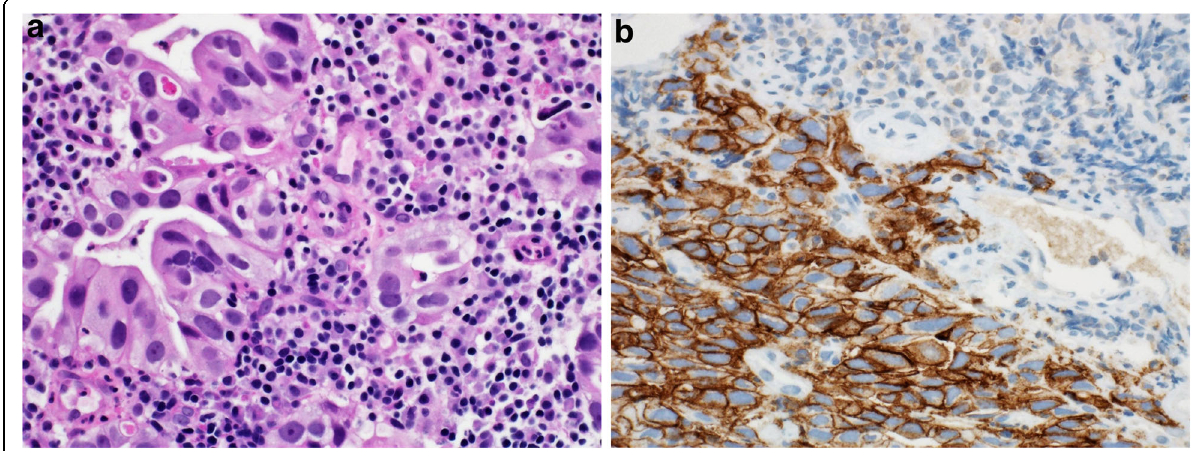
Fig. 14 A Case of moderately differentiated gastric adenocarcinoma. B Immunohistochemical staining of the tumor in which only tumor cells are positive for PD-L1; while tumor immune cells are negative. CPS: 80. (DAKO 22C3